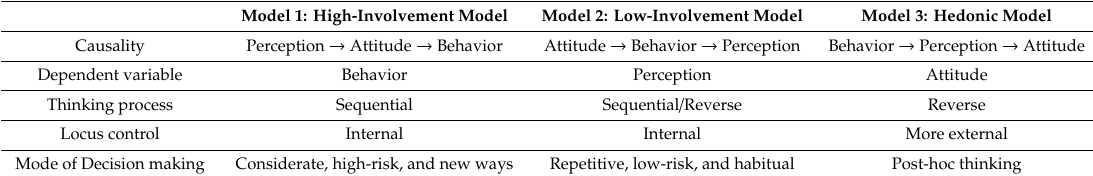
Table 1. Summary of three